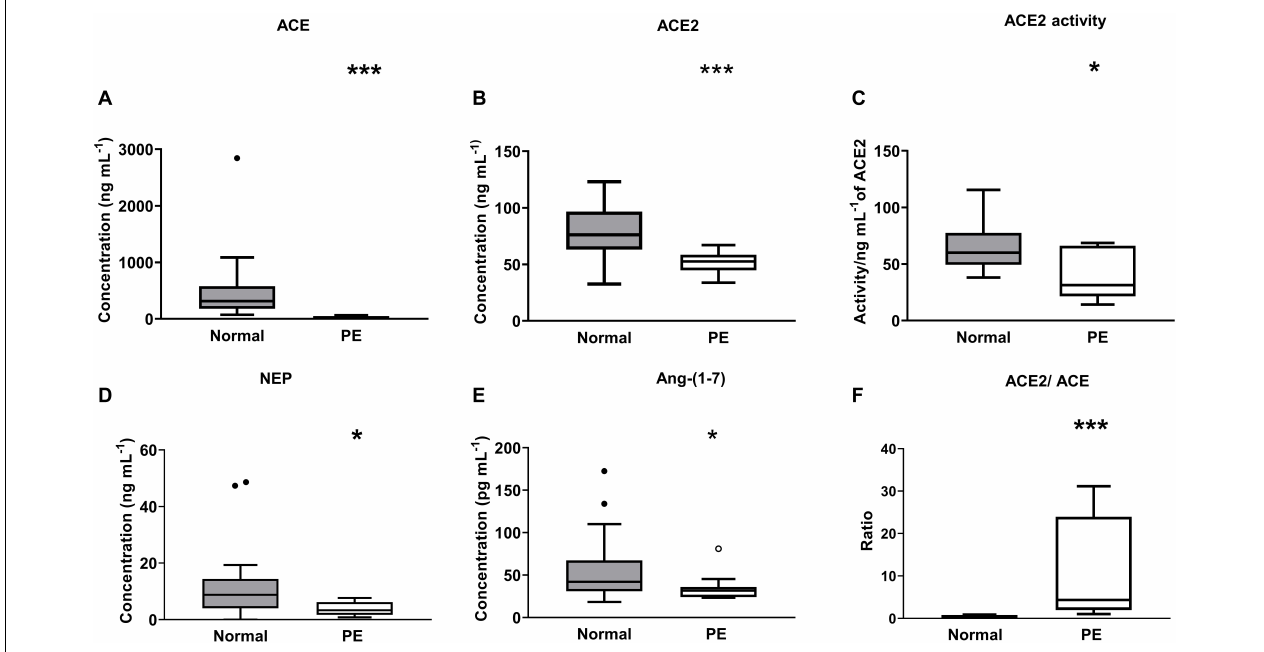
FIGURE 5 | Plasma levels and activity of (A) ACE, (B,C) ACE2, and (D) NEP as well as (E) levels of Ang-(1-7), and (F) ACE2/ACE ratio in the third trimester ( ≥ 26 weeks of gestation) in women with normal pregnancies (gray box) and women with preeclampsia (PE; white box). Data are expressed as median and interquartile range. n = 16–32 for normal pregnancy group and n = 8–14 samples for the PE group. * P < 0.05, ** P < 0.01, *** P < 0.001 versus normal pregnancy group. TABLE 2 | Correlations between maternal sACE, sACE2, and sACE2 activity and birth weight centile (BWC). 13 weeks 18 weeks 30 weeks 36 weeks sACE vs.